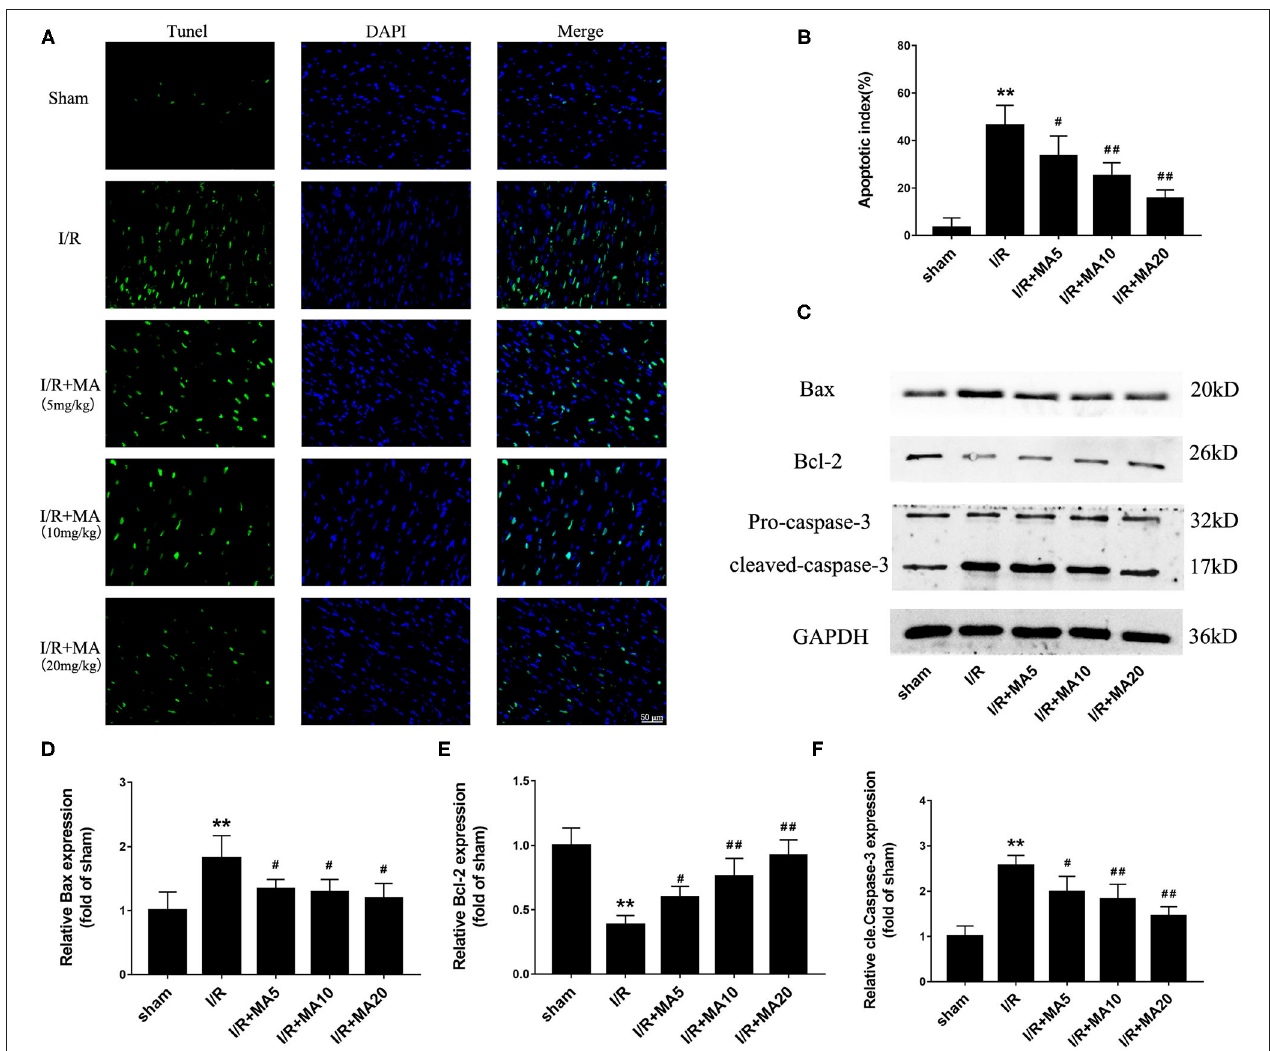
FIGURE 7 | Maslinic acid treatment suppressed I/R-induced myocardial apoptosis in vivo . (A,B) Terminal deoxynucleotidyl transferase-mediated dUTP nick-end labeling (TUNEL) staining was used to assess the myocardial apoptosis and green fluorescence of the nucleus is indicative of apoptosis. The quantitative analysis of the mean apoptotic index is shown in the bar graphs ( n = 4). (C) Western blot was performed to assess the expression of apoptosis-related proteins (Bax, Bcl-2, and cleaved caspase-3) in myocardial tissue under I/R conditions. (D–F) The quantitative analyses of the apoptosis-related proteins are shown in bar graphs ( n = 3). All data are expressed as mean ± SD. ** P < 0.05 vs. control group; # P < 0.05, and ## P < 0.01 vs. H/R